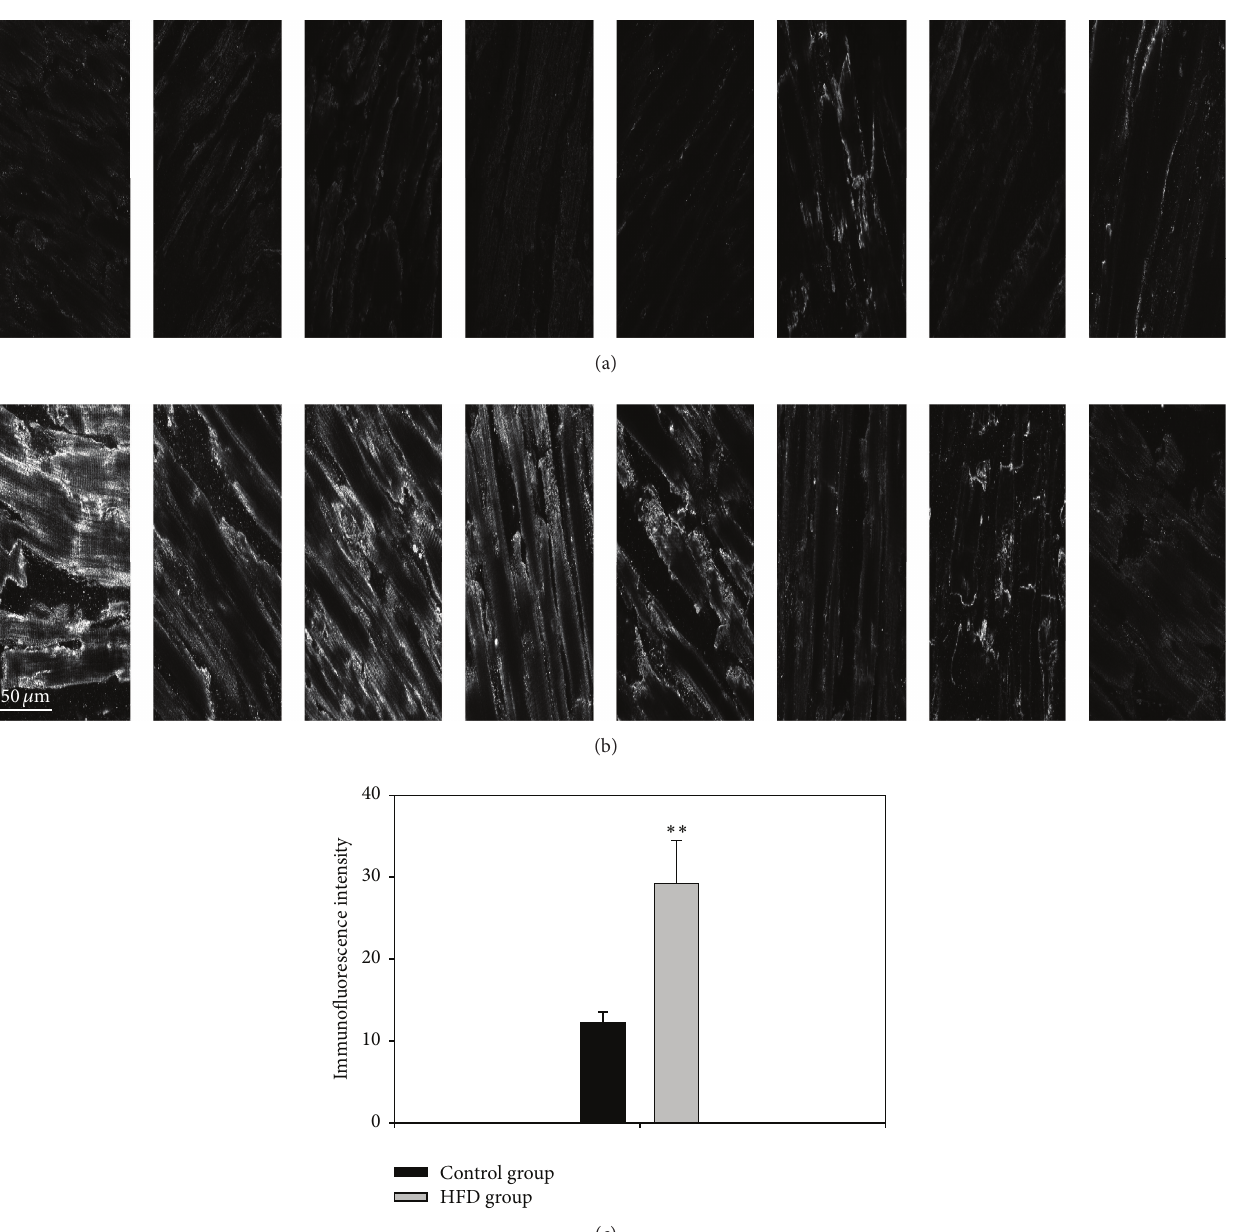
Figure 4: Representative images of HCN4 immunolabelling (white signal) in the left ventricle of control (a) and obese (b) animals. (c) Mean ± SEM signal intensity in arbitrary units of HCN4 immunolabelling in the left ventricle of the control and obesity groups ( 𝑛 = 8 /group). ∗∗ Significantly different from the control group ( 𝑃 < 0.01